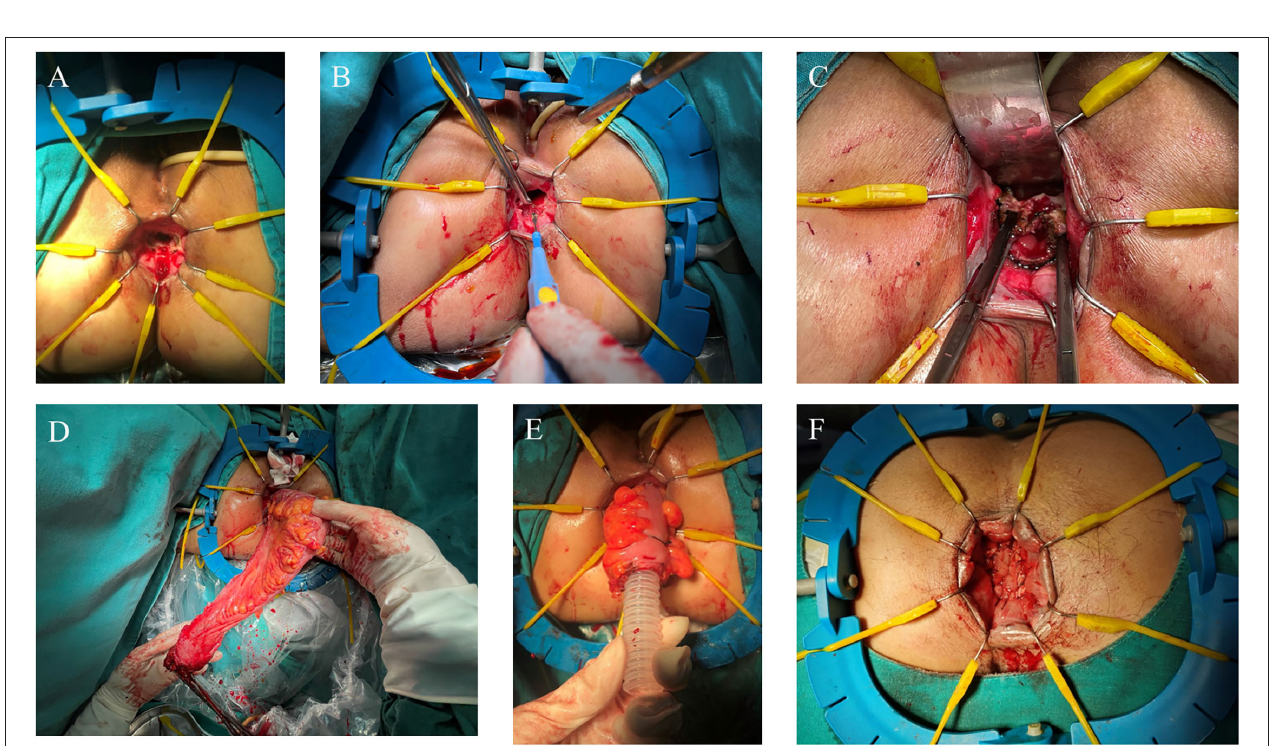
FIGURE 2 | Perineal phase of PE-Bacon procedure. (A) Expose the anal canal; (B) dissect the rectum at the level of 1cm from the distal margin of the rectal lesion; (C) dissect the rectum along the intersphinteric plane; (D) pull through the colon and rectum and transect the diseased bowel; (E) first-stage coloanal anastomosis. (F) second-stage coloanal